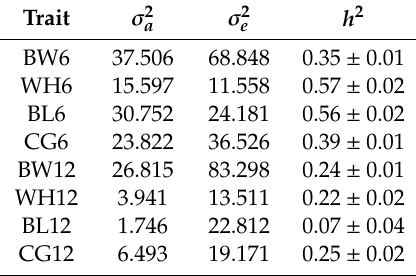
Table 2. Variance component estimation and the heritability of four traits for two stages of development.